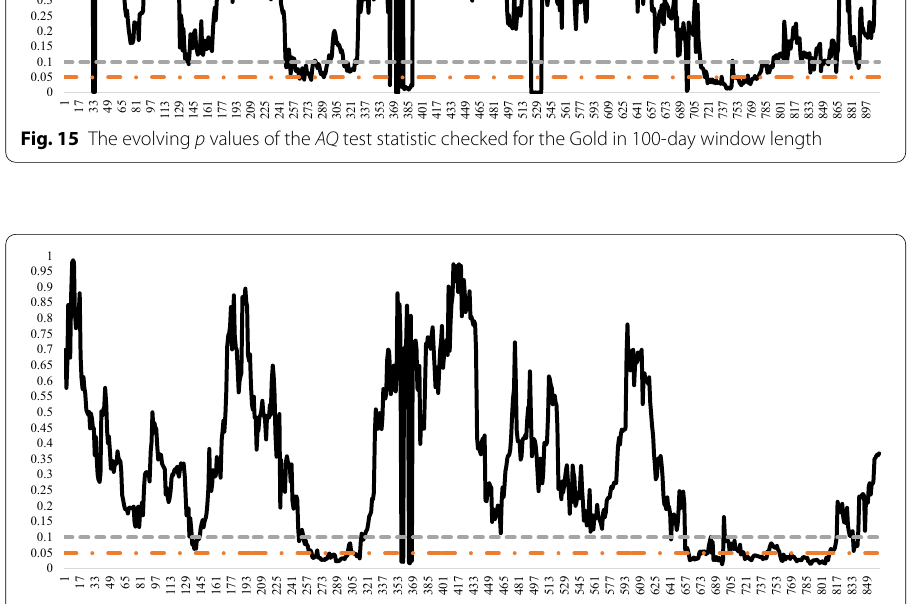
Fig. 16 The evolving p values of the AQ test statistic checked for the Gold in 150-day window length